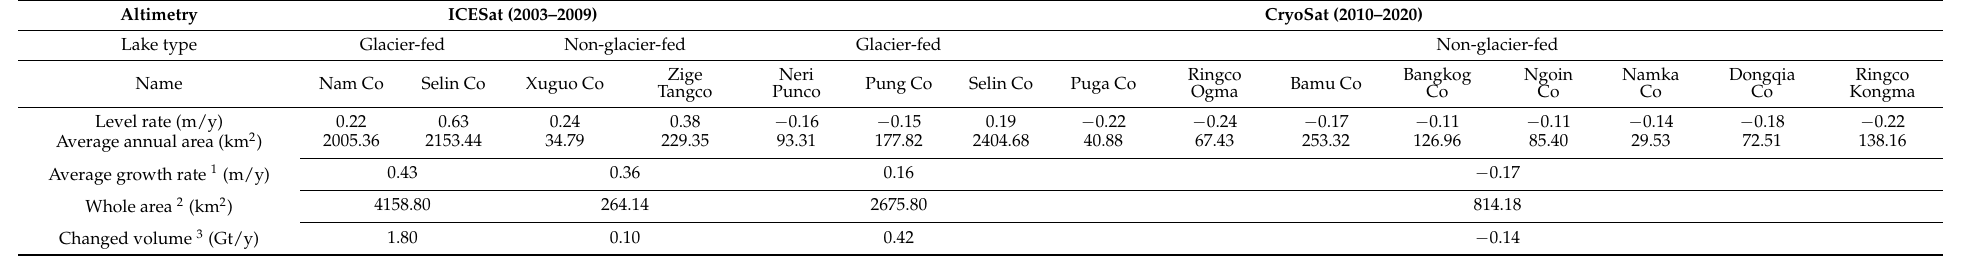
Table 3. Comparison between glacier-fed and non-glacier-fed lakes in terms of water level change rate, area, and lake volume changes in 2003–2020.